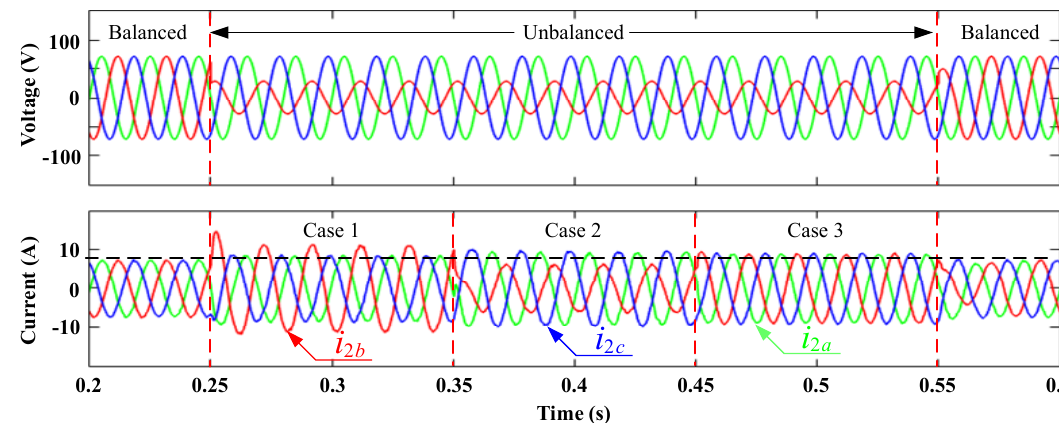
Figure 7. Simulated grid voltage and grid-injected current under unbalanced grid voltage condition in three cases.